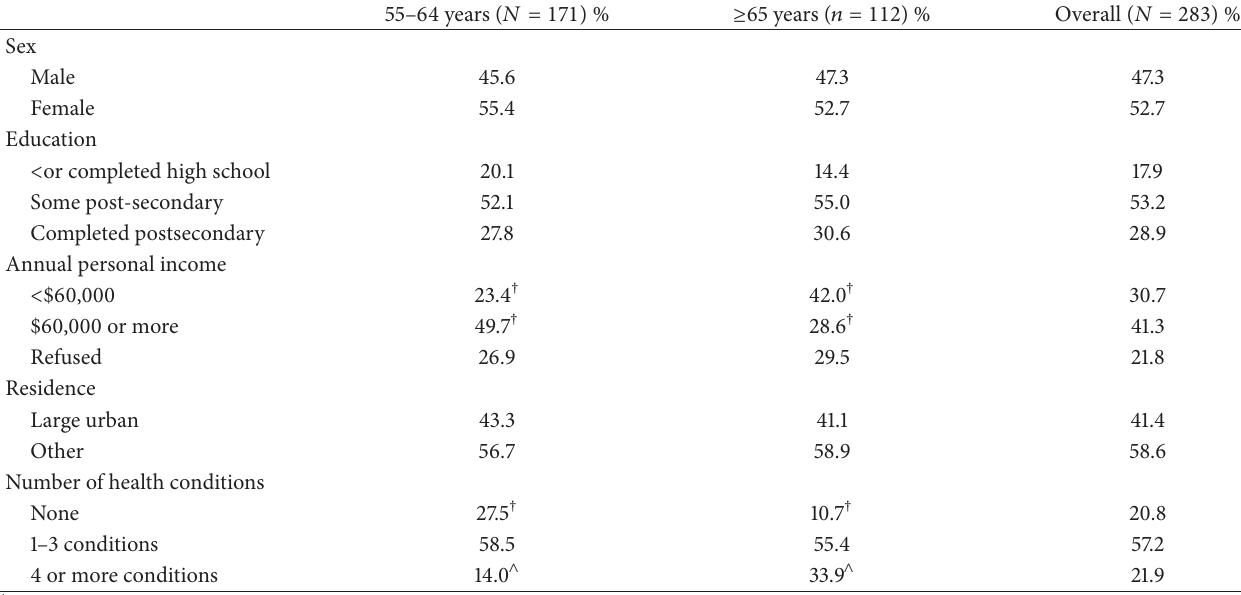
Table 1: Demographic and health characteristics of the sample (by age group and overall).